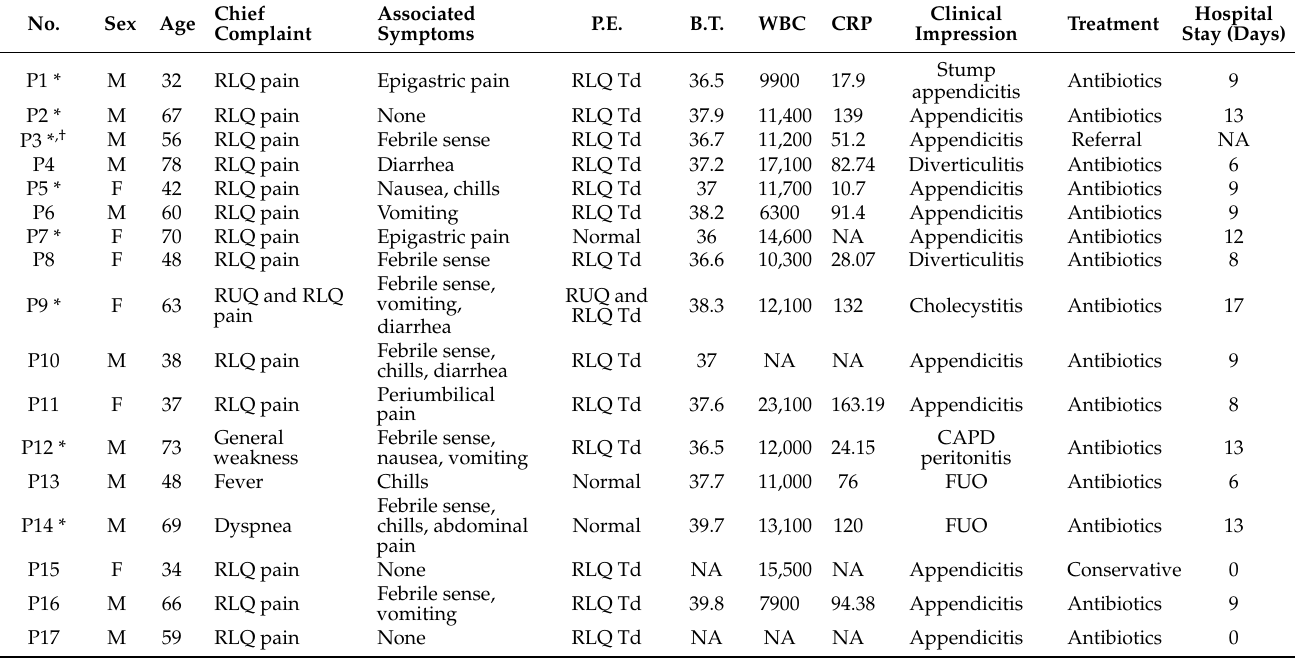
Table 1. Clinical characteristics of the 17 patients with acute ileal